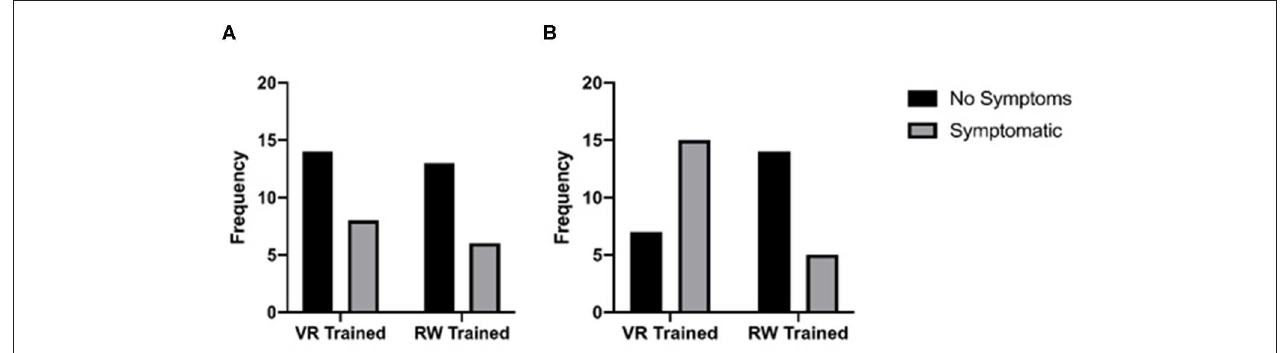
FIGURE 4 | Frequency distributions of symptom reporting (A) before training and (B) after